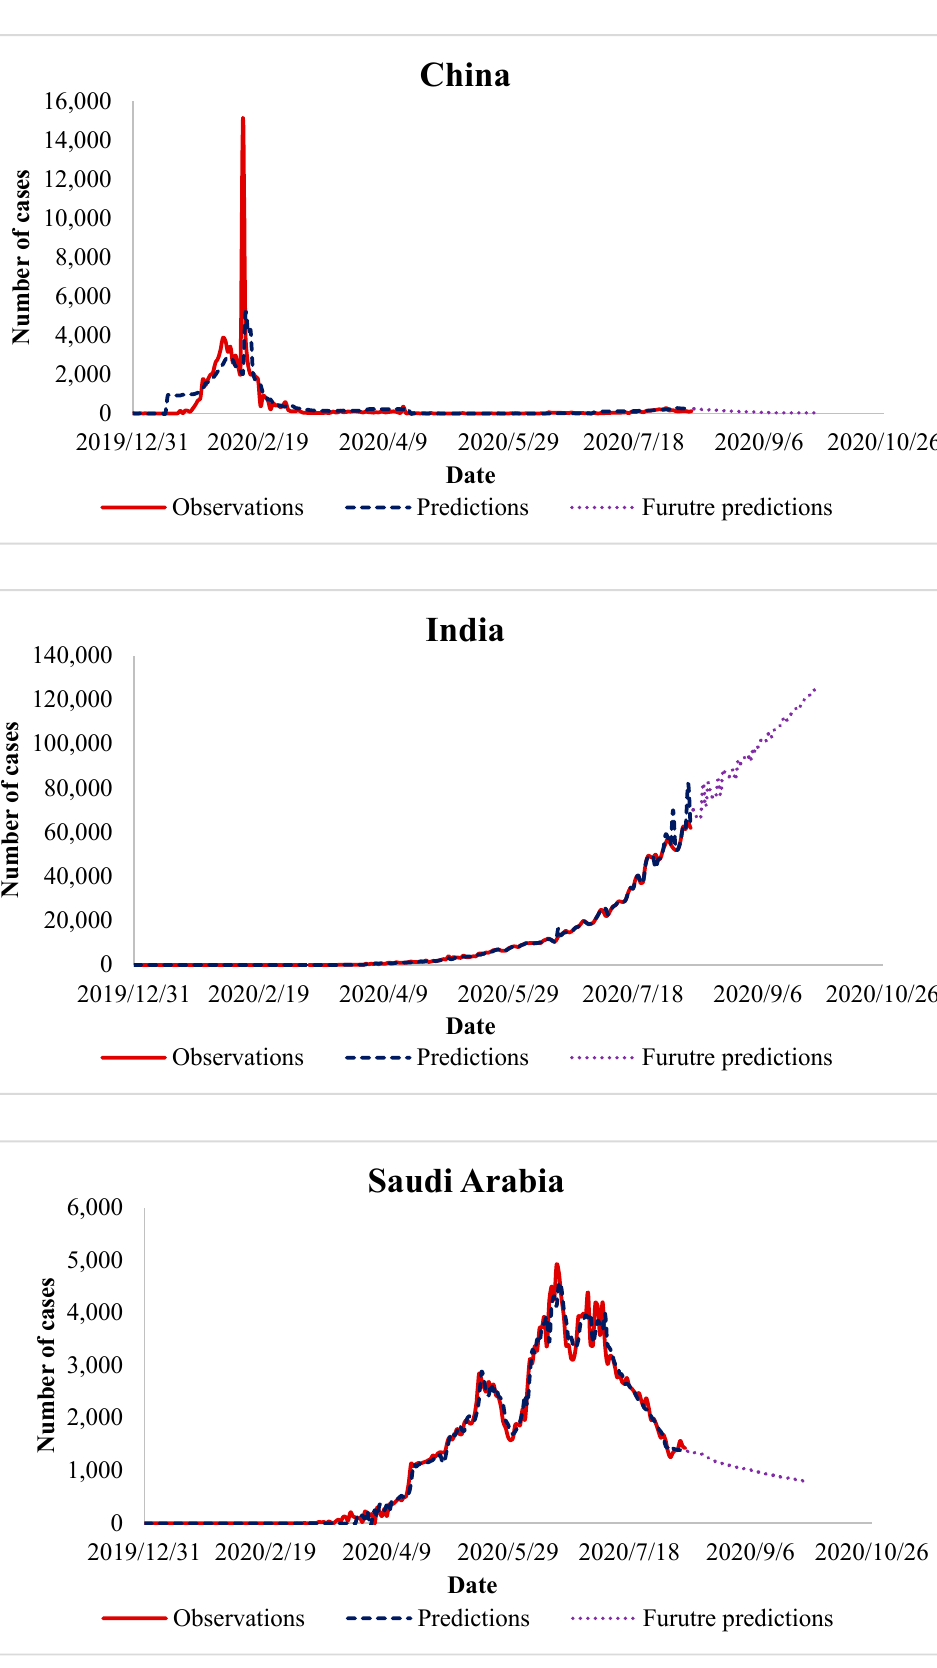
Figure 7. Future prediction of COVID-19 cases in Asian countries.